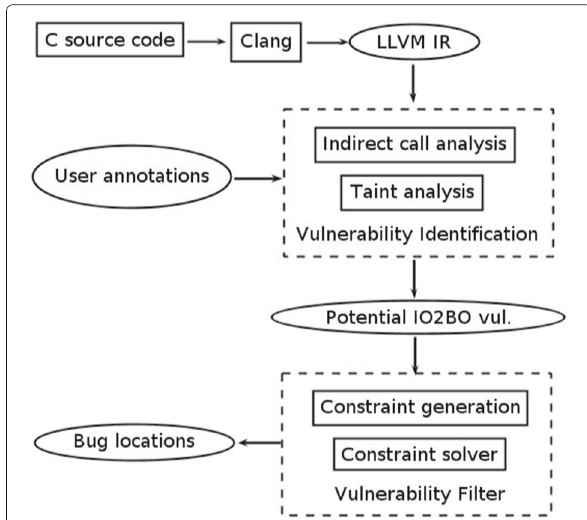
Fig. 1 The structure of our